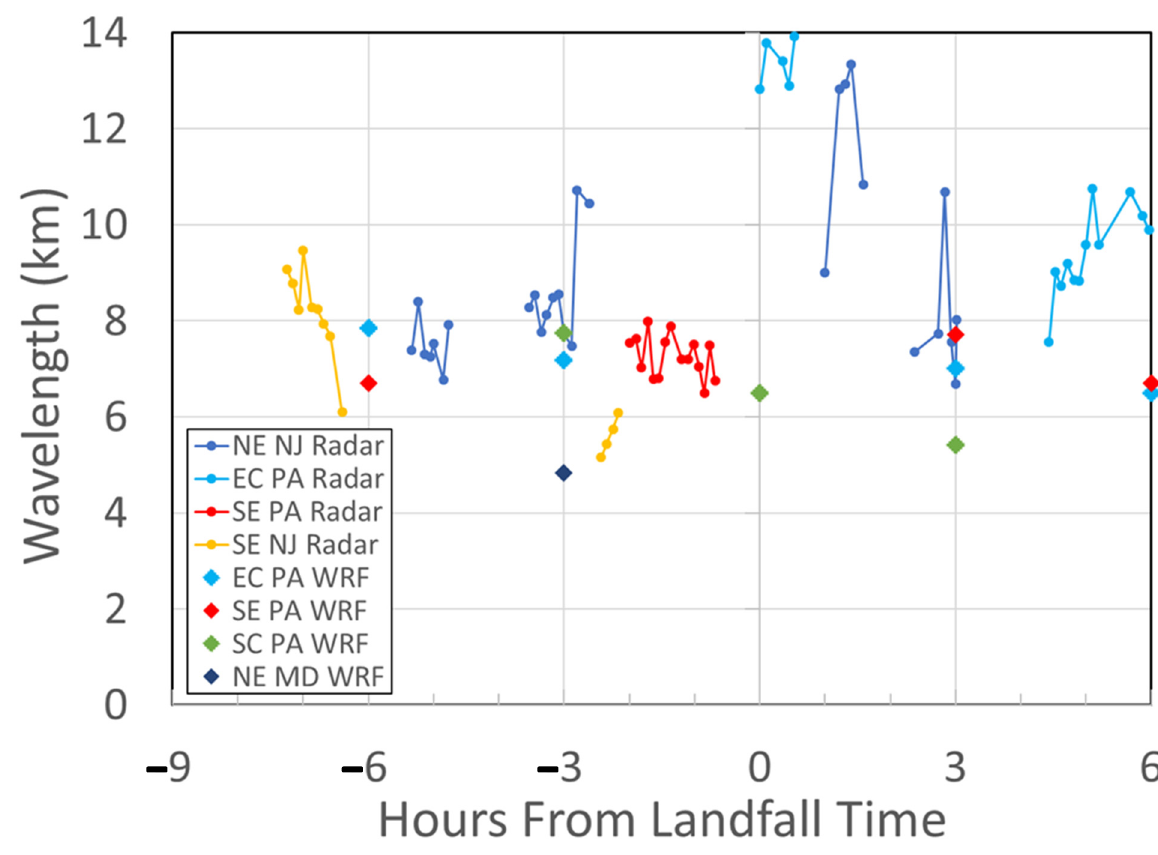
Figure 7. The roll wavelengths quantified based on radar observations (points and solid lines) and from Weather Research and Forecasting (WRF) simulation (diamonds) for regions where rolls were prevalent and plotted versus time relative to landfall time.